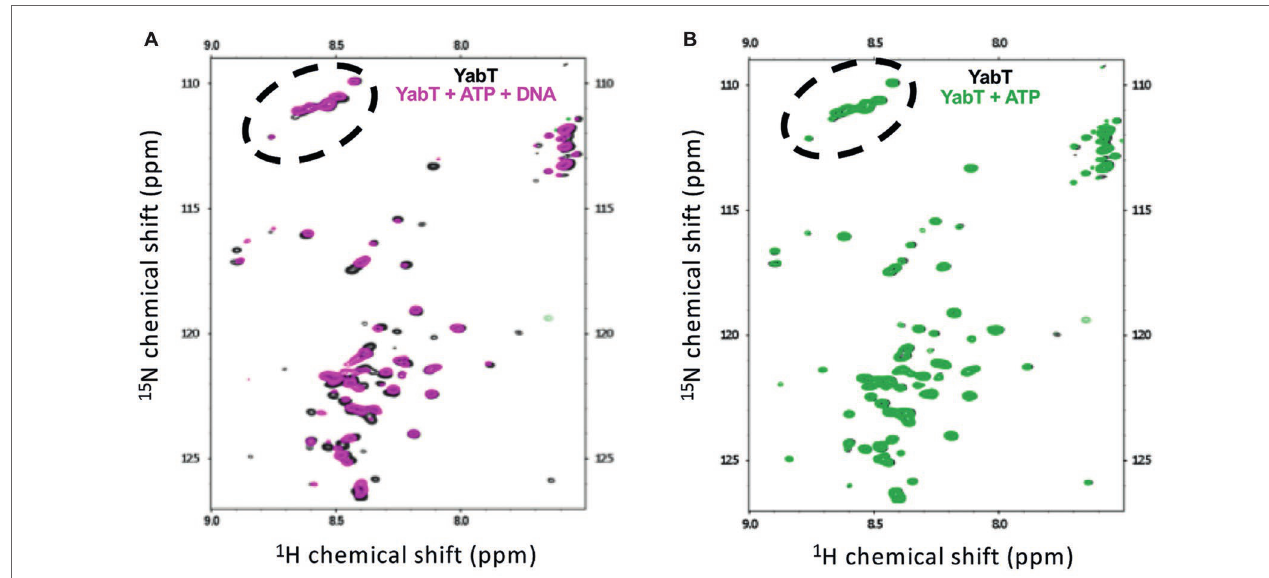
FIGURE 6 | NMR analysis of YabT in the presence and absence of DNA. Superimposition of the Sofast 1 H- 15 N HMQC NMR spectra of isotopically labeled 6His- YabT( ∆ TM) alone (in gray) (A) , after addition of ATP and DNA (in magenta), and (B) , after addition of ATP alone (in green). Each peak represents a bonded N-H pair, with its two coordinates corresponding to the chemical shifts of each of the H and N atoms. Only the region of the spectra corresponding to disordered residues is shown. The peaks corresponding to glycine residues are circled by dashed